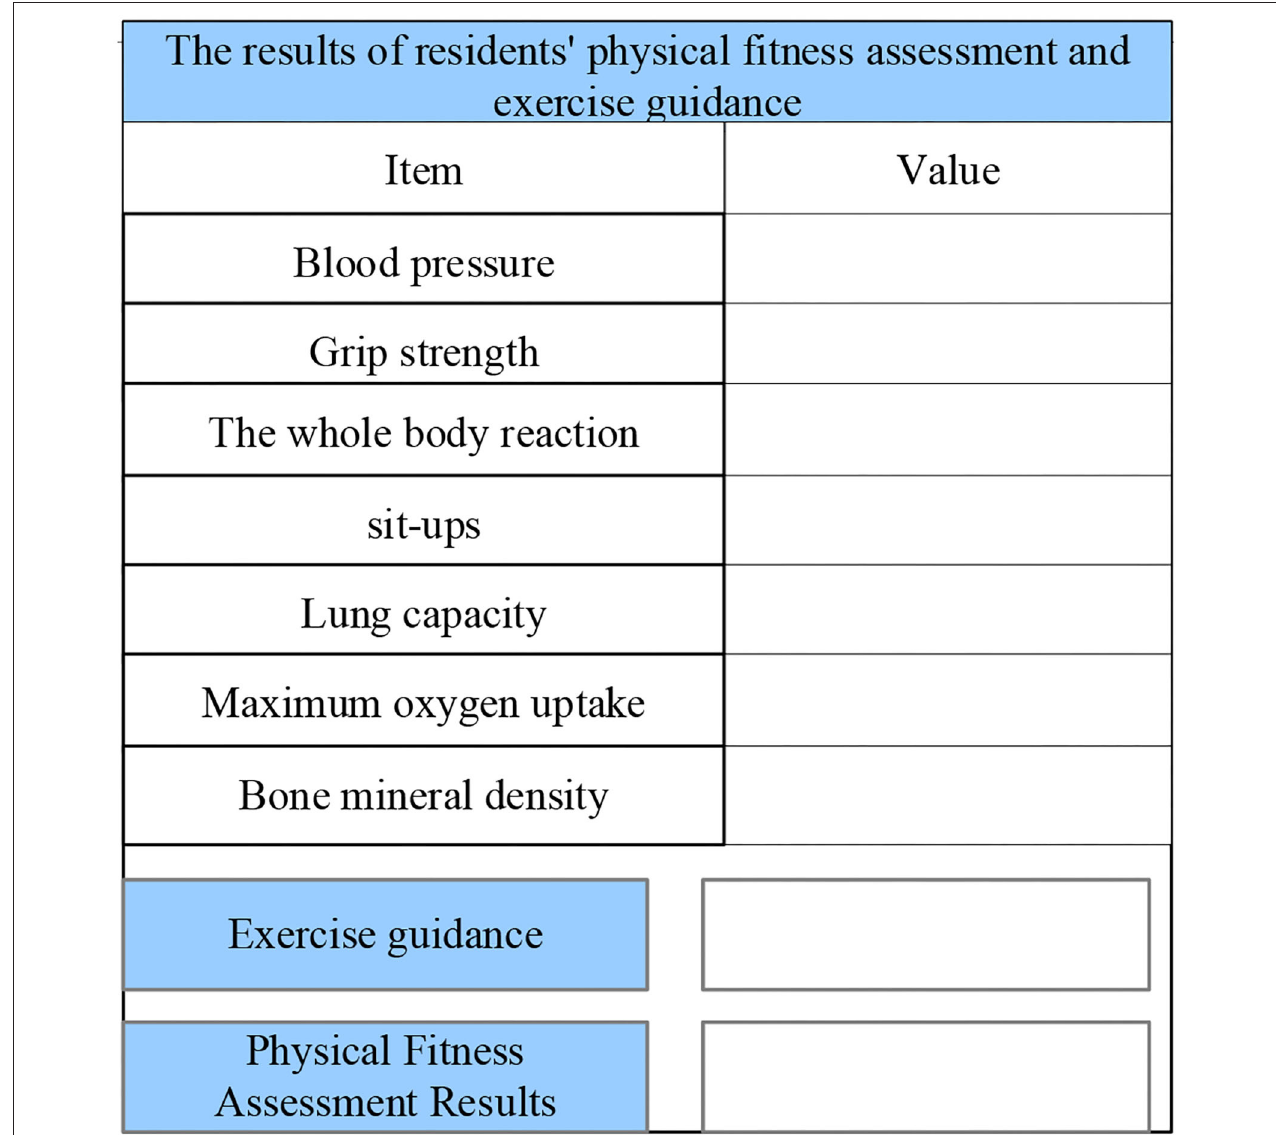
FIGURE 21 | The interface for the generated physical fitness evaluation